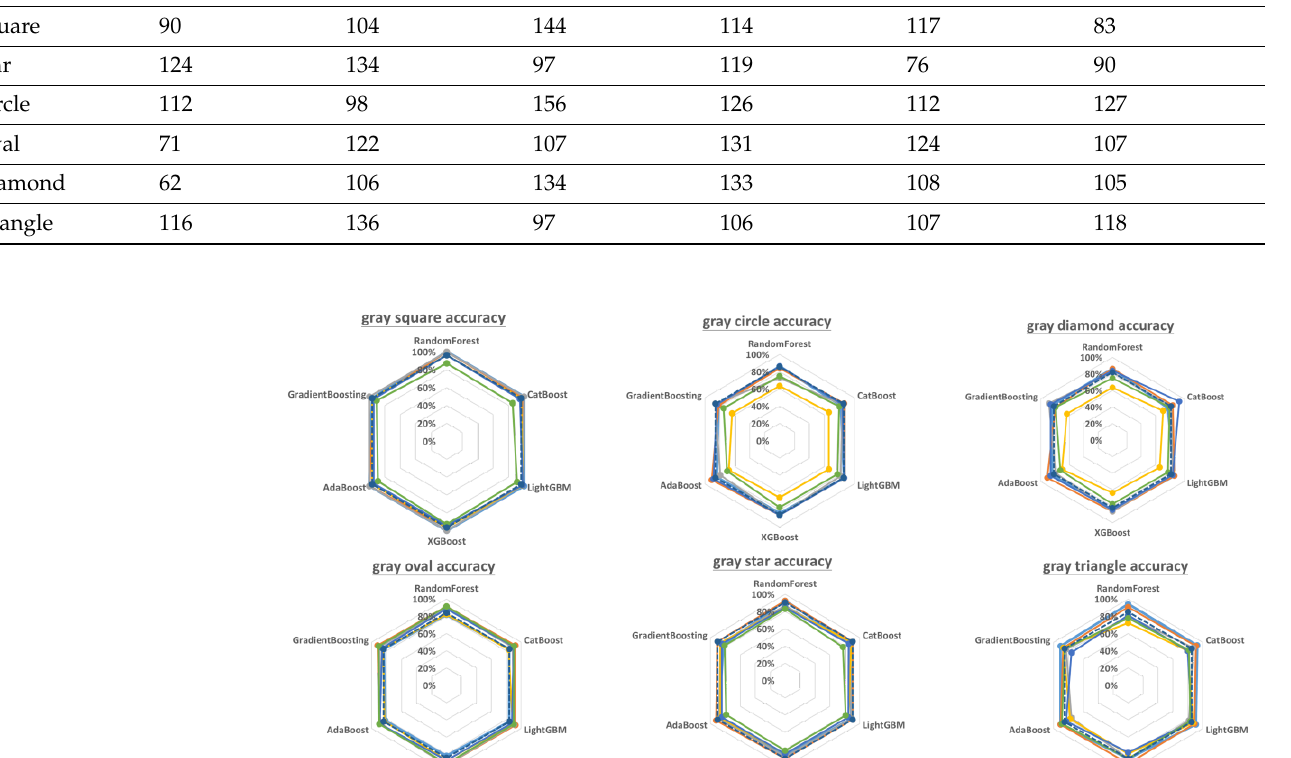
Table 2. Statistics of the dataset.